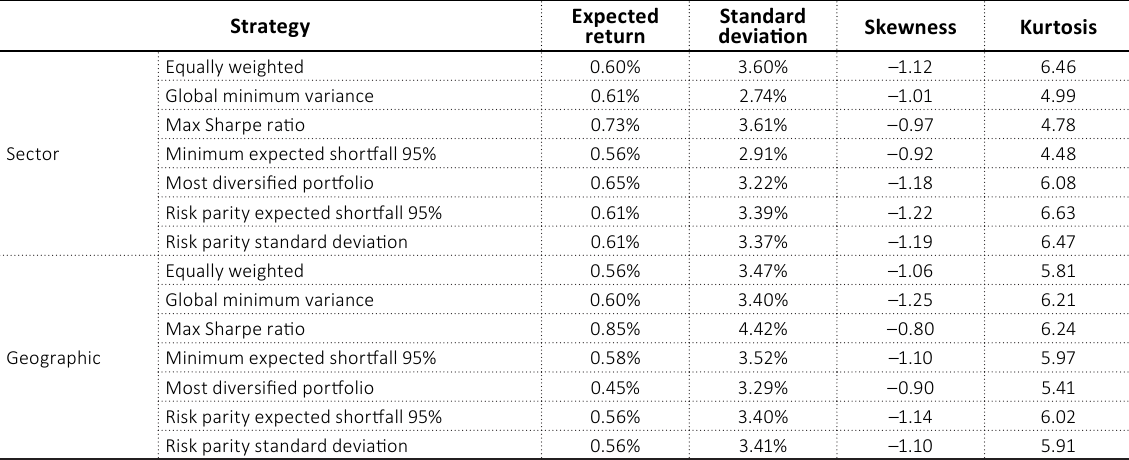
Table 6. Descriptive statistics of the portfolios’ excess